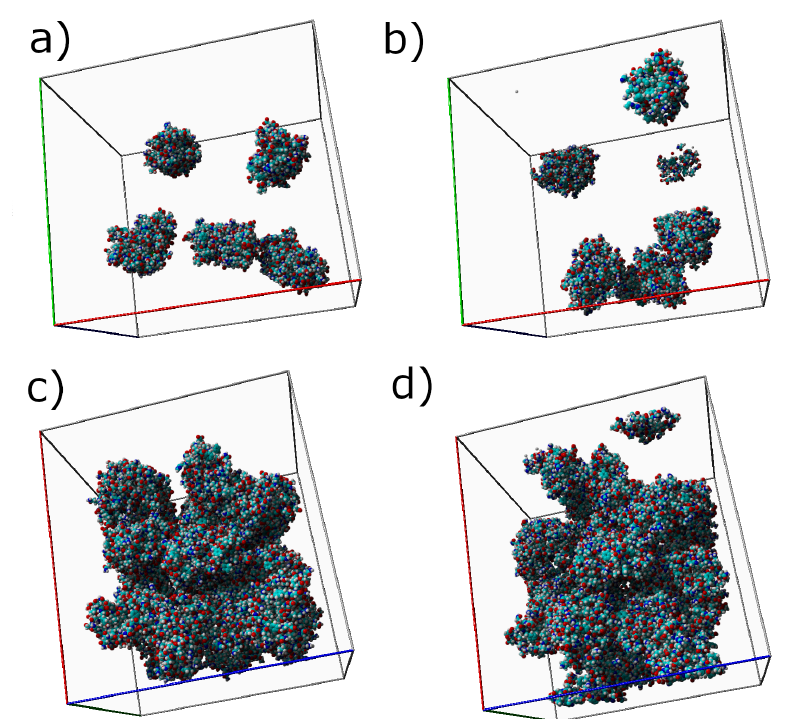
Figure 2. Initial ( a , c ) and final ( b , d ) structures of the mucin network. ( a , b ) show simulation boxes for c 1 , and ( c , d ) show simulation boxes for c 5 . Light blue atoms represent carbon, dark blue nitrogen, red oxygen, yellow sulfur, and white hydrogen. Note that the proteins are fragmented due to the periodic boundary conditions on each wall.